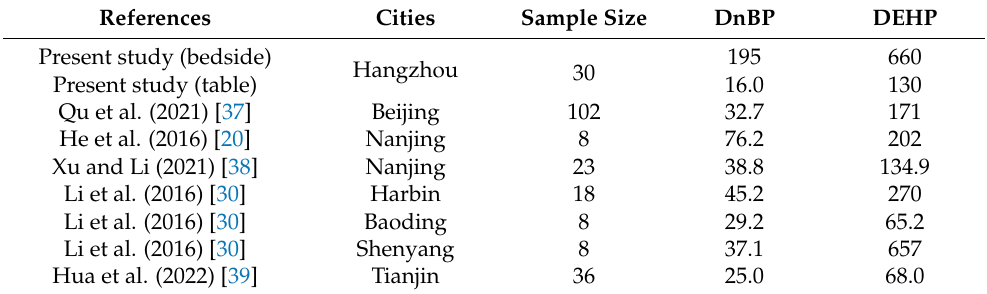
Table 3. Mediansofdust-phaseconcentrationsofDnBPandDEHP( µ g/g)inChineseuniversitydormitories.